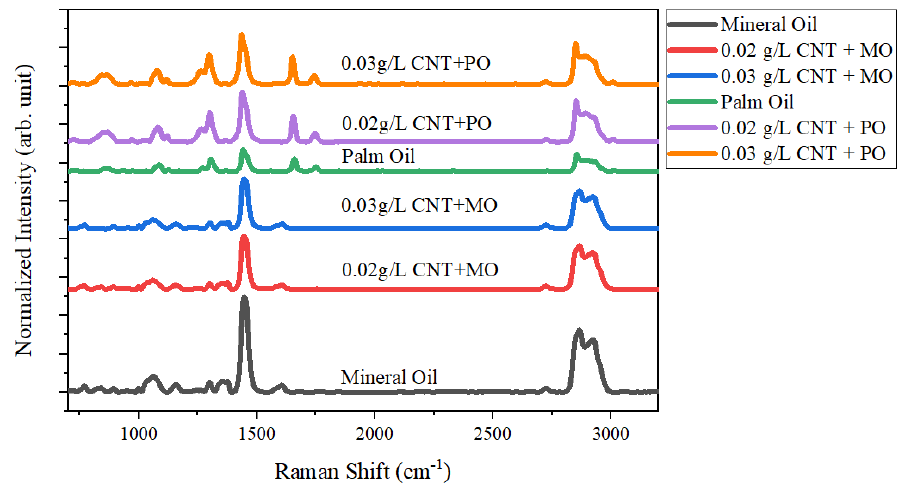
Figure 3. A stacked plot of Raman spectrum after normalization process.